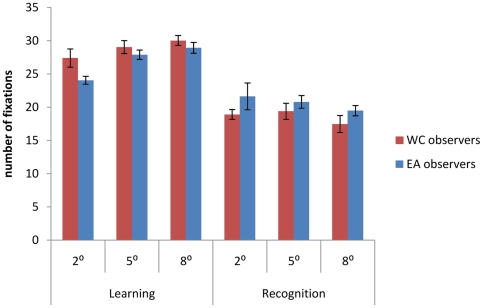
Number of average fixations employed by Western Caucasian (WC) and East Asian (EA) observers to adapt to face learning and recognition across the different Spotlight apertures sizes.